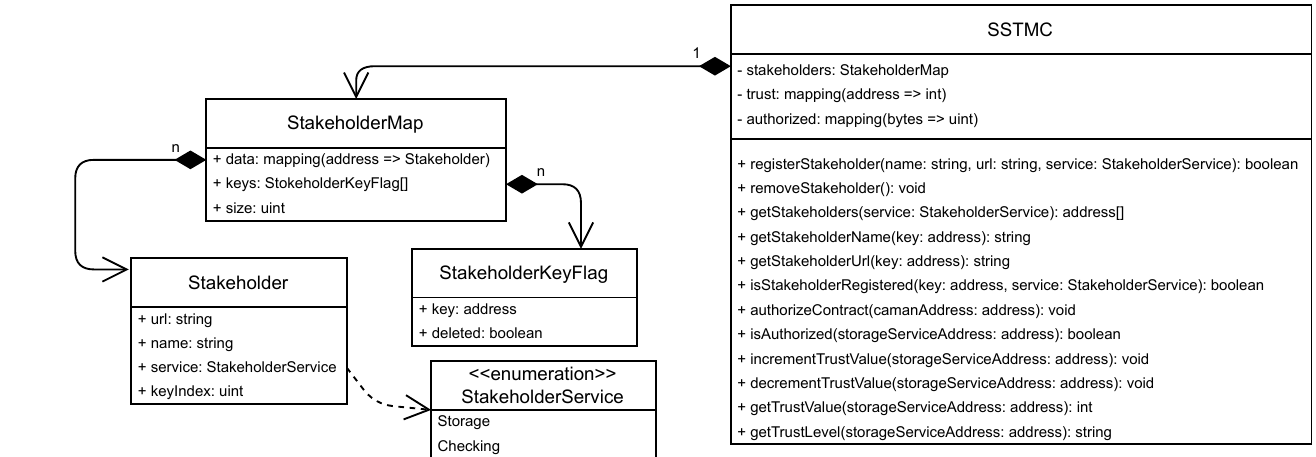
Figure 2. Class diagram of the